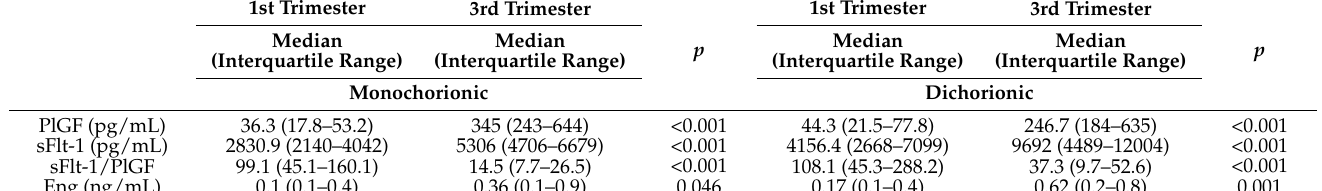
Table 2. Serum concentrations of placental growth factor (PlGF), serum soluble fms-like tyrosine kinase-1 (sFlt-1), sFlt-1/PlGF and endoglin (Eng) measured in the first trimester and the third of pregnancy in monochorionic and dichorionic groups.